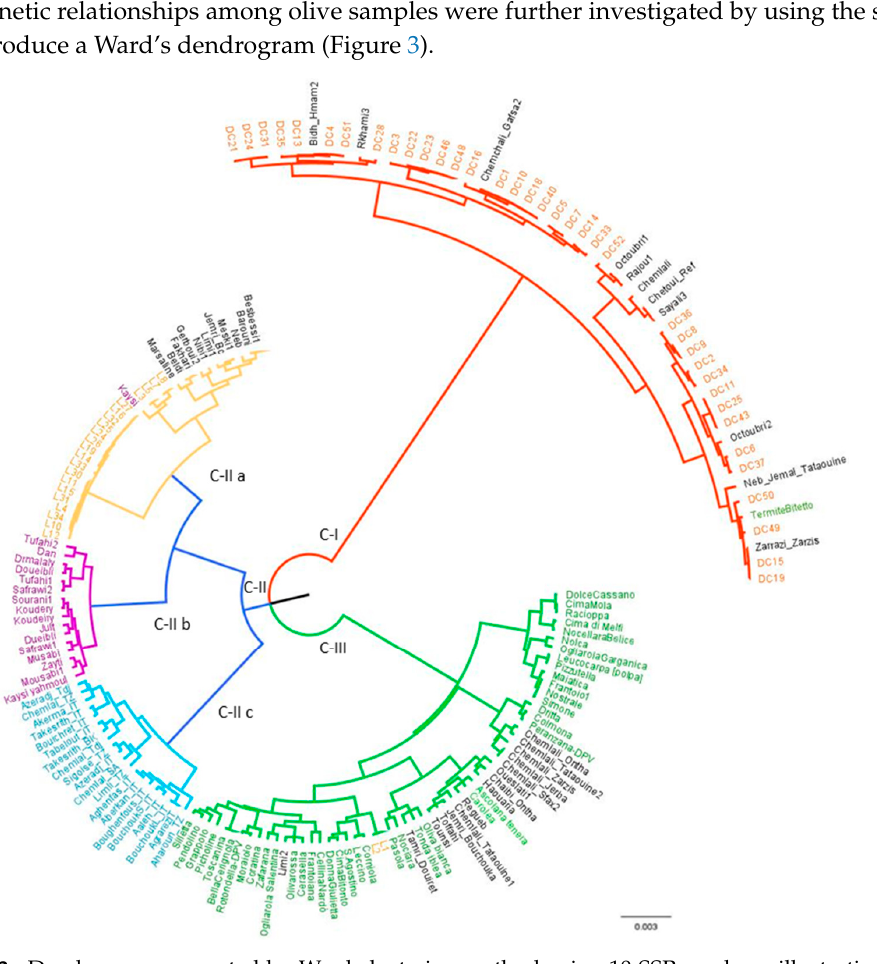
Figure 3. Dendrogram generated by Ward clustering method using 10 SSR markers, illustrating the phylogenetic relationships among the analyzed olive genotypes originated from Degache oasis (orange, C-I), Lebanon (yellow, C-II a), Syria (purple, C-II b), Algeria (blue, C-II c), Italy and Tunisia (green, C-III).